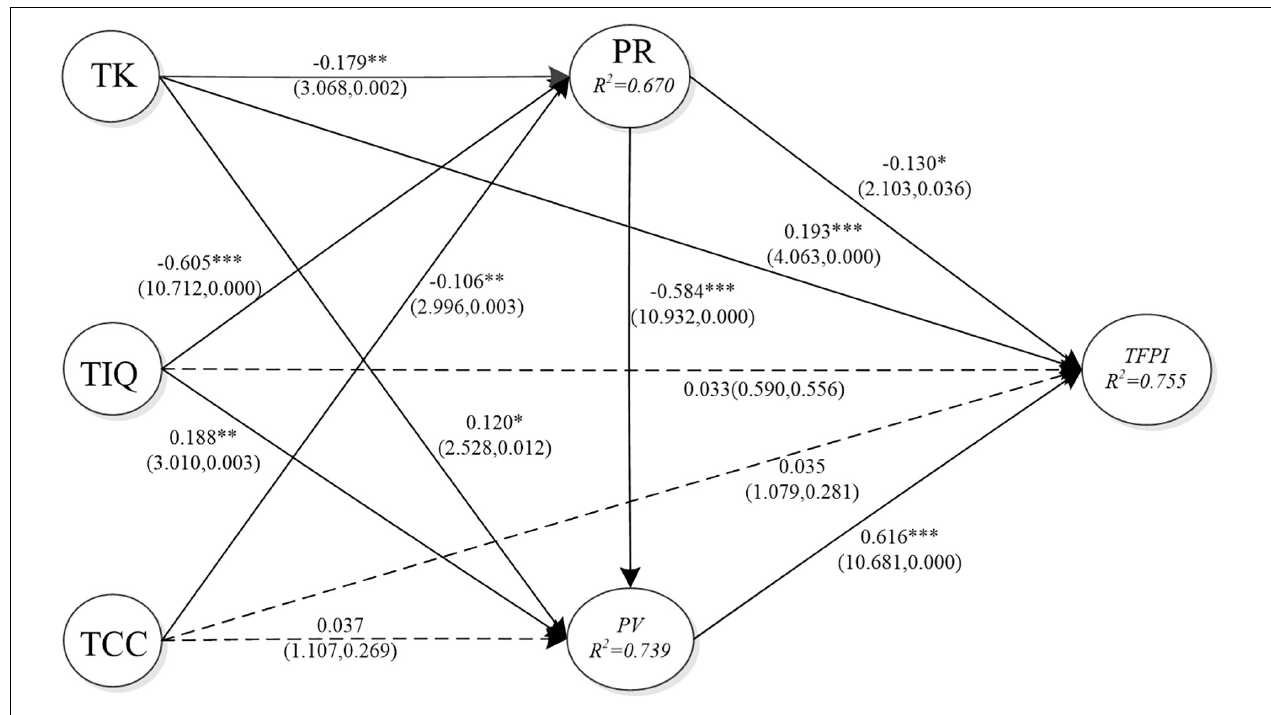
FIGURE 2 | Standardized path coefficients and significance of the inner model.